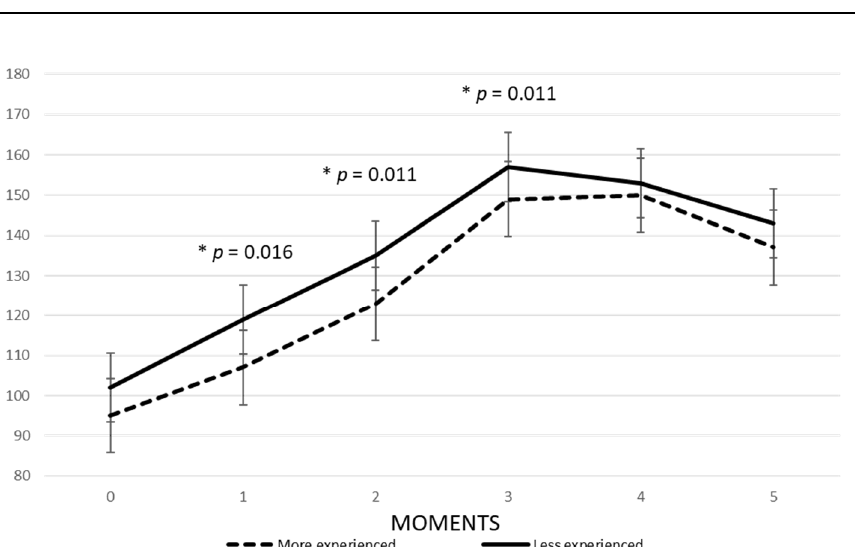
Figure 1. HR AVG at different moments of the jump related to the variable level of experience.